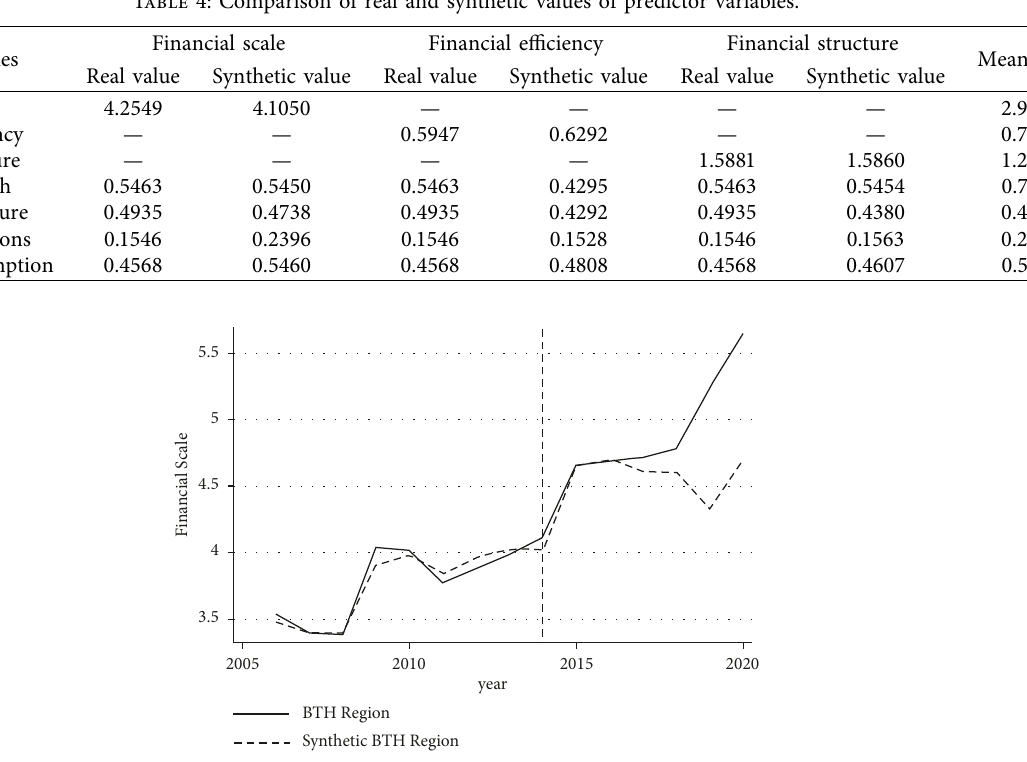
Figure 4: The BTH region and the synthetic BTH region’s financial scale change trend.